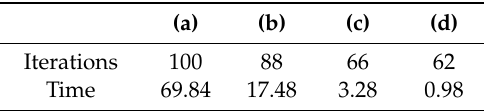
Table 2. Execution time (in seconds) of the FCM algorithm on multi-resolution images shown in Figure 5 ( c =